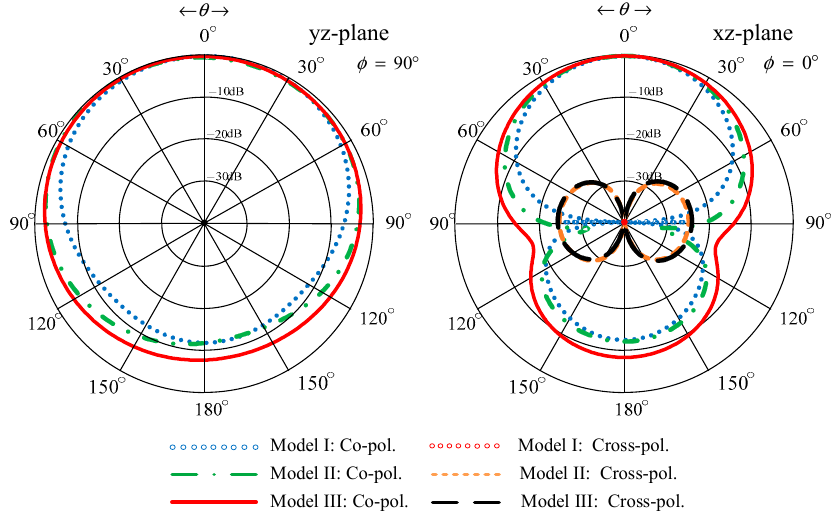
Figure 6. Simulated xz- and yz-plane radiation patterns of the antenna models I, II, and III.